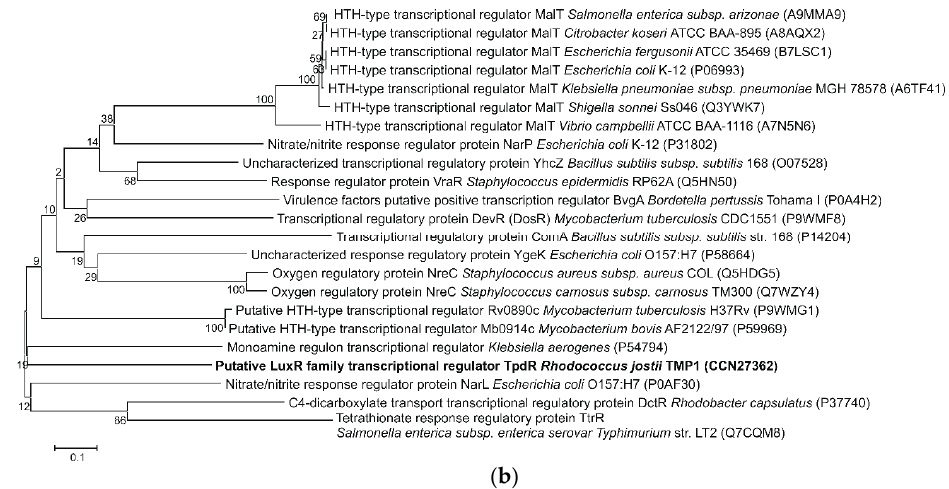
Figure 6. ( a ) Domains and motifs identified in the TpdR protein. ( b ) Neighbour-joining tree based on the alignment of the amino acid sequences of the C-terminal HTH LuxR domain of TpdR protein from Rhodococcus jostii TMP1 and other functionally diverse proteins from different bacteria. The percentage of replicate trees in which the associated taxa clustered together in the bootstrap test (500 replicates) are shown next to the branches. The evolutionary distances were computed using the Poisson correction method. All positions containing gaps and missing data were eliminated from the dataset using the complete deletion option. The scale bar represents the expected amino acid substitutions per position. The GenBank accession number is indicated for each protein. The phylogenetic analysis was performed using MEGA 5.0 [27].